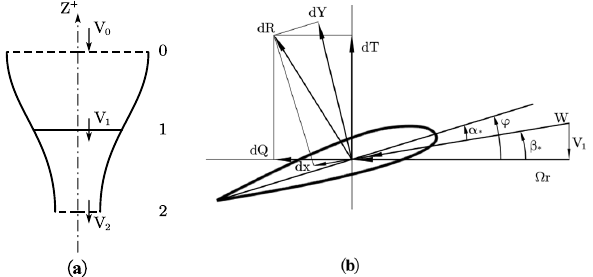
Figure 1. Rotor’s airflow in the momentum ‐ element model. ( a ) Momentum theory description. ( b ) Element theory description.